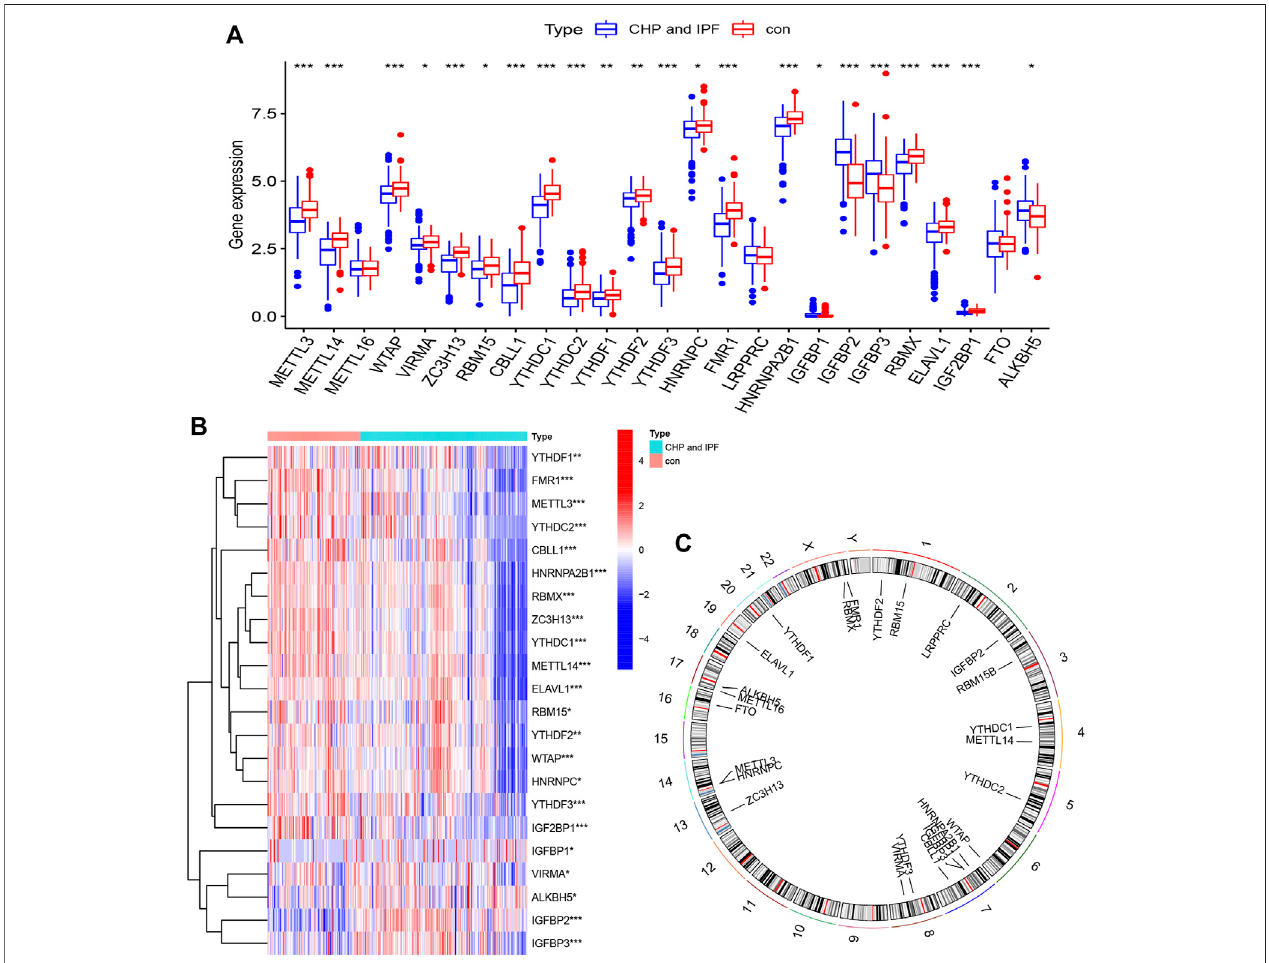
FIGURE 1 | Landscape of the N6-methyladenosine (m6A) regulators in CHP and IPF (A) The differential expression histogram of 25 m6A regulators between controls and tests. (B) The differential expression heatmap of 22 m6A regulators. (C) Chromosomal positions were visualized using the “ RCircos ” package. * p < 0.05, ** p < 0.01, and *** p <